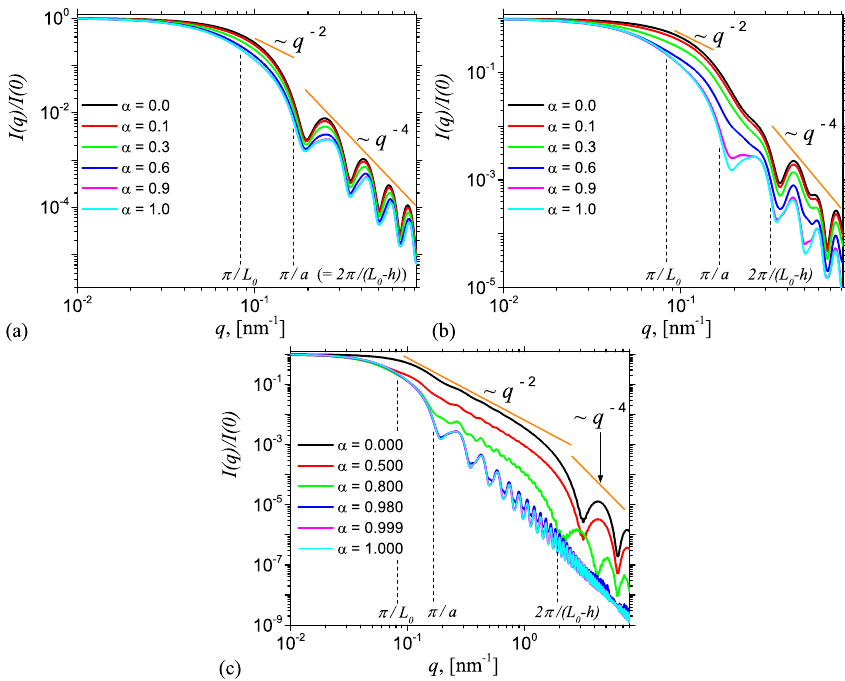
Figure A2. (Color online) SAS intensity from radially symmetric cylinders with diameter 2 a = 40 nm and height 2 L 0 = 80 nm, when Region 2 is found at various heights h above a middle-plane parallel to the bases: ( a ) h = 0 nm; ( b ) h = 20 nm; and ( c ) h = 38 nm.